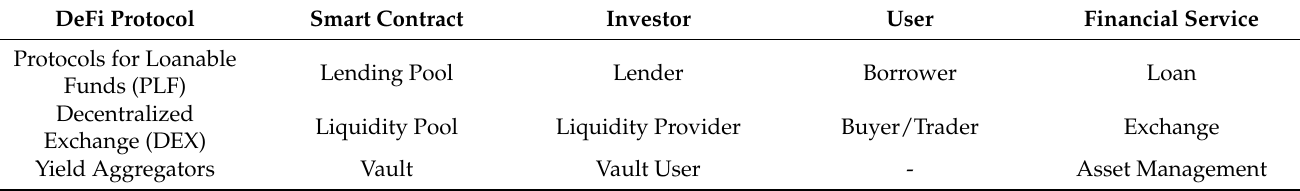
Table 1. DeFi Protocols